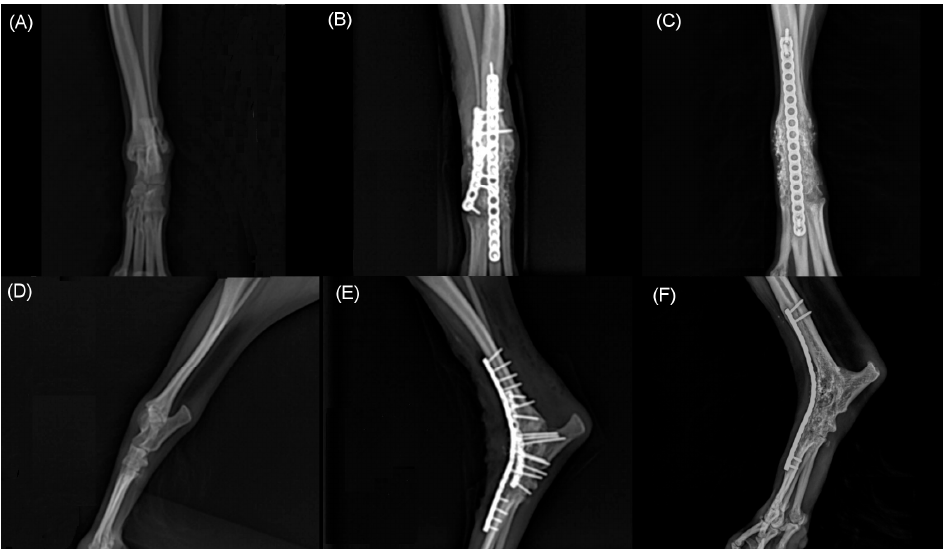
Figure 5. Craniocaudal ( A , B , C ) and mediolateral ( D , E , F ) radiographs of right tarsal joint. Note hyperextension of tarsal joint before surgery ( A , D ). Immediate postoperative radiographs ( B , E ) shows pantarsal arthrodesis performed using double 1.2 mm locking plate place on dorsally. At 21 months postoperative radiographs shows complete bony union and remodeling ( C , F